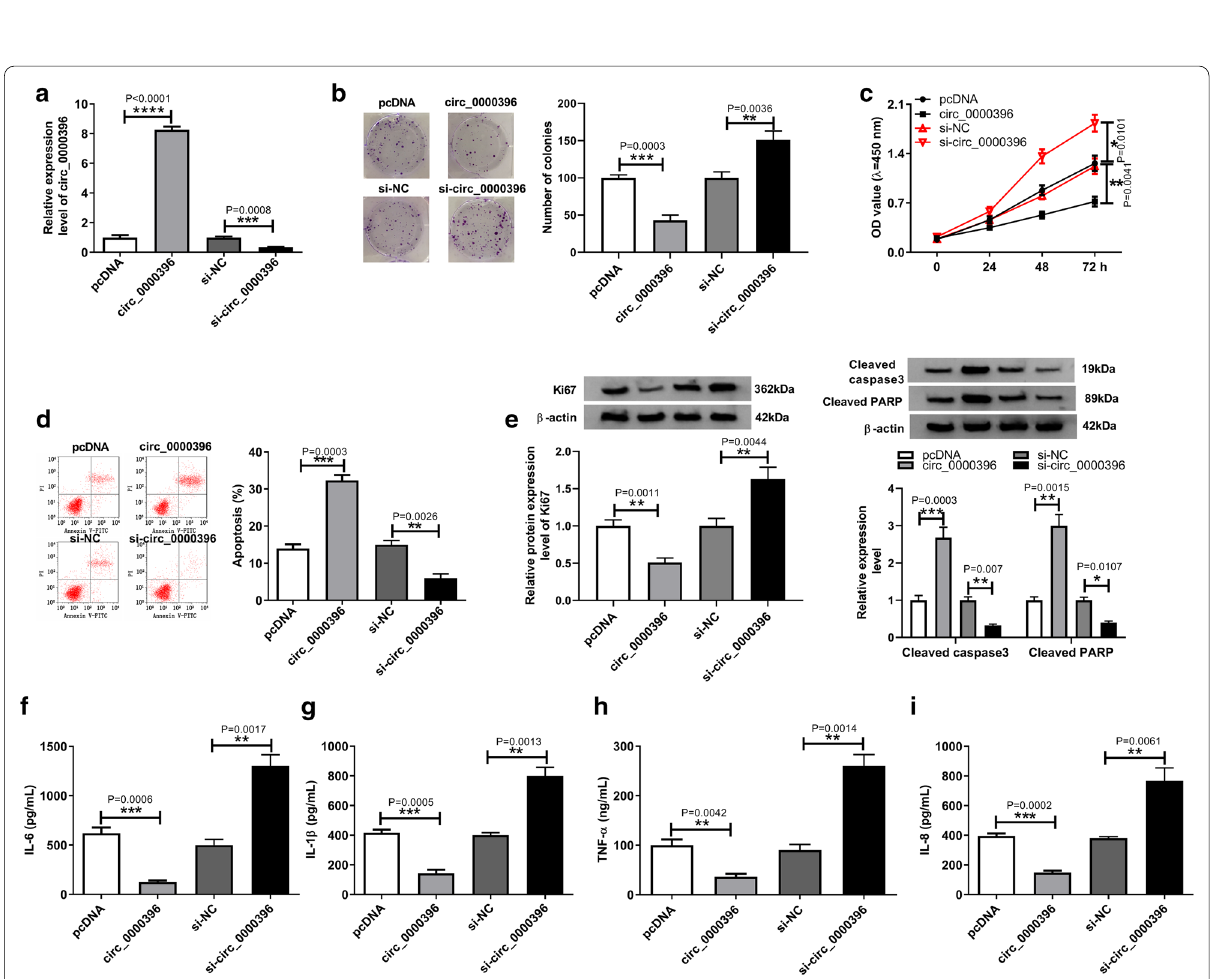
Fig. 2 Effects of circ_0000396 on the growth and inflammation of RASFs. RASFs were transfected with pcNDA, circ_0000396, si-NC, or si-circ_0000396. After transfection, a circ_0000396 expression was detected by qRT-PCR (Student’s t test); b , c the proliferation of RASFs was analyzed using colony formation assay and CCK-8 assay, respectively (Mann–Whitney U-test); d the number of apoptotic RASFs was examined by flow cytometry (Student’s t test); e western bolt analysis of Ki67, cleaved caspase3 and cleaved PARP expression in RASFs was performed (Student’s t test); f – I the level of inflammatory cytokines IL-6, IL-1β, IL-8 and TNF-α in RASFs was measured using ELISA assay (Student’s t test). * p < 0.05, ** p < 0.01, *** p < 0.001, **** p <